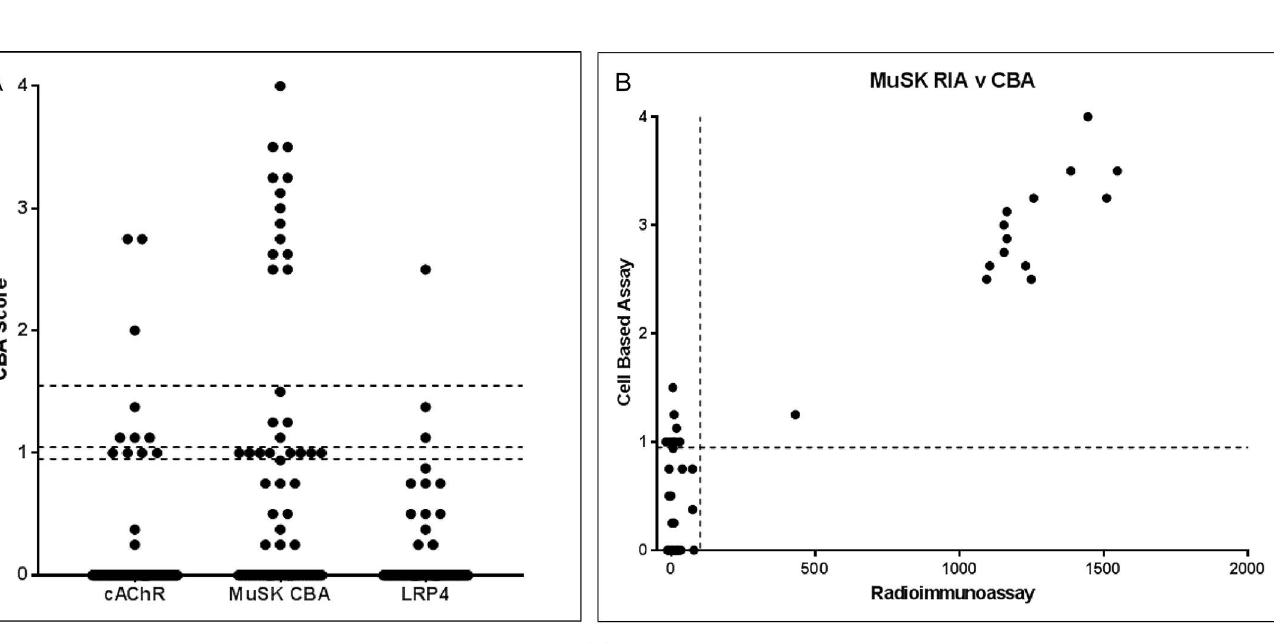
Fig 2. Results of CBA for antibodies to MuSK, LRP4, and clustered AChR (A) and correlation between CBA scores and RIA values for anti-MuSK antibodies (B) MuSK, muscle-specific tyrosine kinase; CBA, cell-based assay; LRP4, low-density lipoprotein receptor-related protein 4; AChR, acetylcholine receptor; RIA, radioimmunoassay.